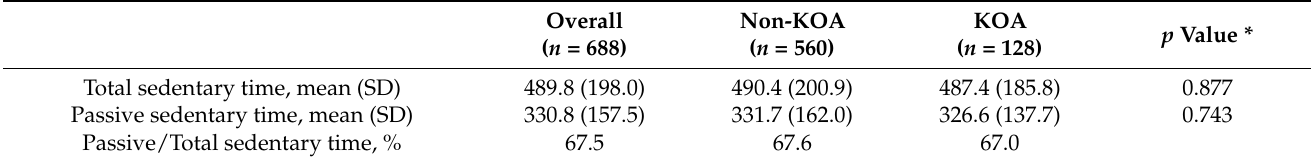
Table 2. Descriptive statistics of total and passive sedentary